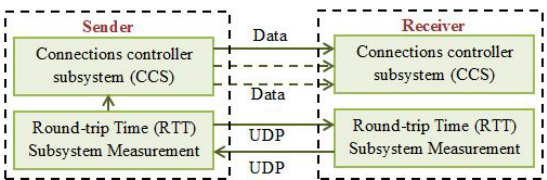
Fig. 7. The proposed enhanced multiple –TCP